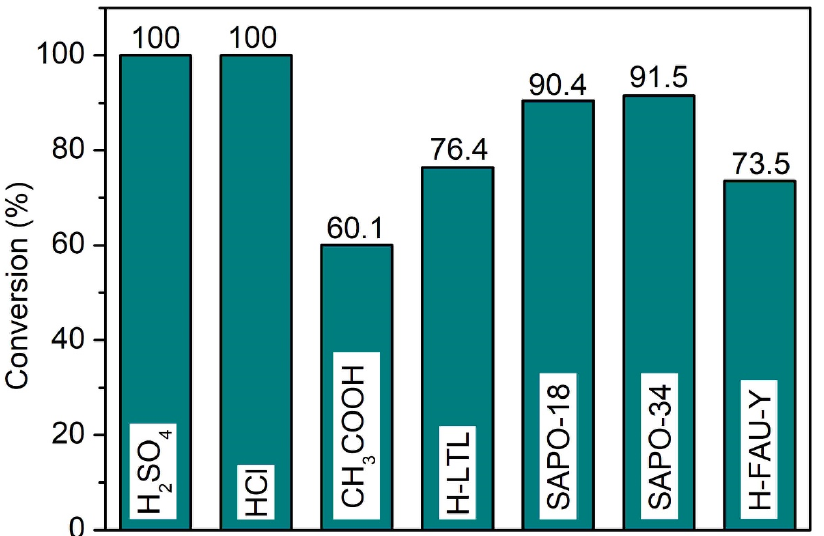
Figure 10. Catalytic performance of various homogeneous and heterogeneous acid catalysts in the esterification of levulinic acid with 1 ‐ propanol. Reaction conditions: Catalyst loading = 7.70 μ mol equivalent to 0.100 g SAPO ‐ 34; 1 ‐ propanol:levulinic acid molar ratio = 11:1; reaction temperature = 190 °C; heating time = 20 min; microwave power = 800 W; solvent ‐ free.